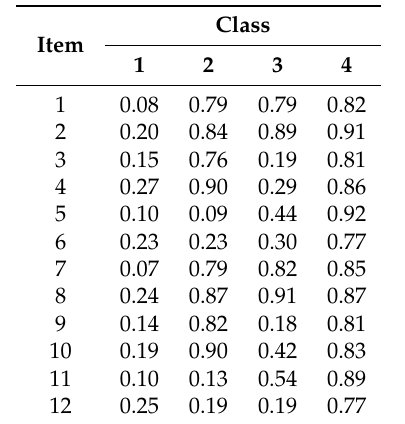
Table 3. Data illustration dichotomous data: estimated item response probabilities in exploratory LCM with C = 4 classes.